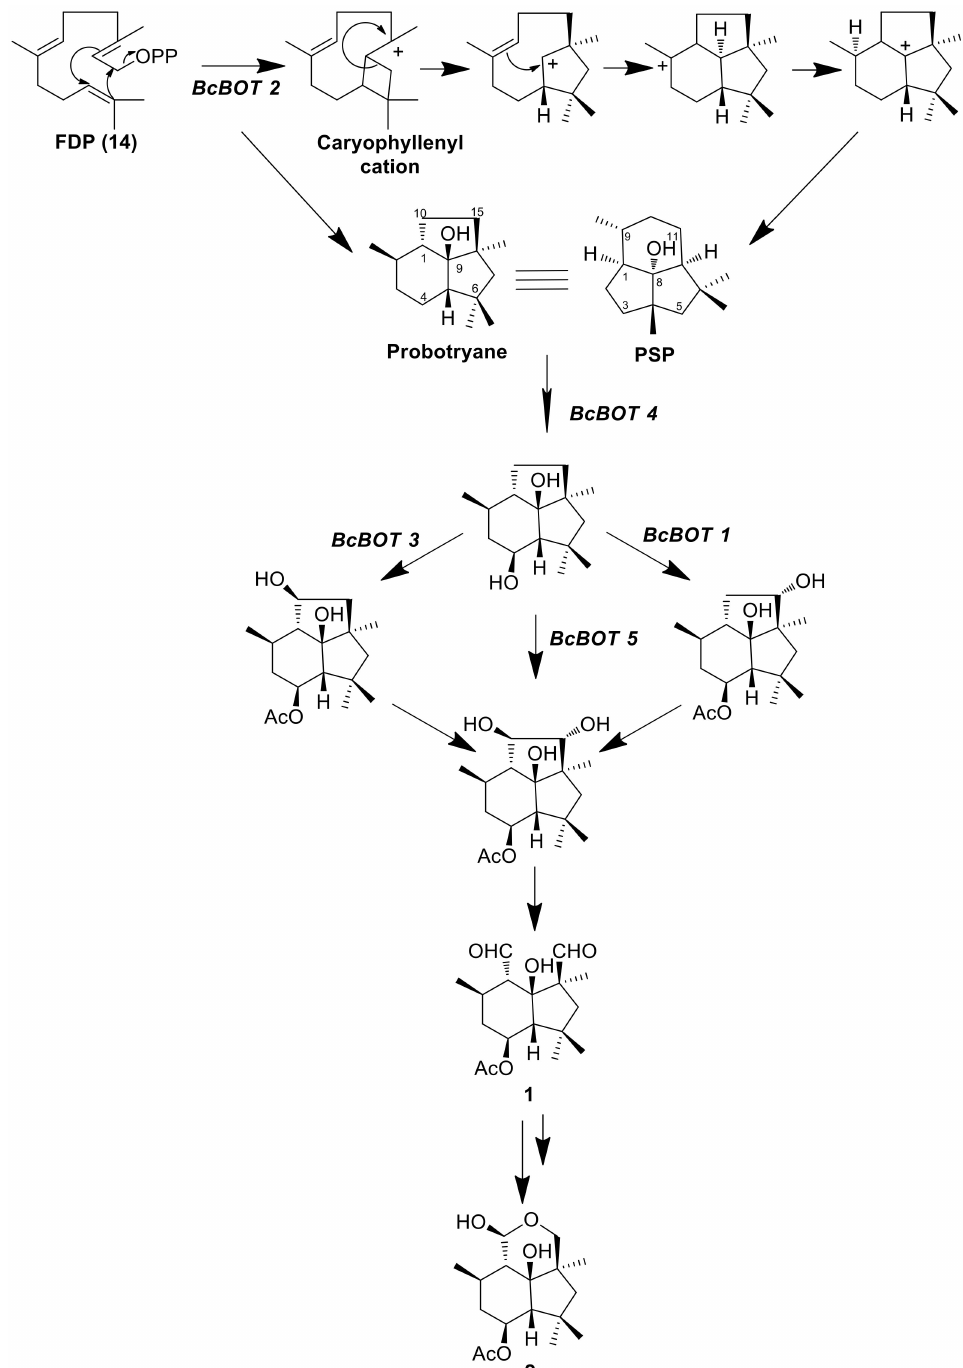
Figure 9. Biosynthetic pathway from FDP ( 14 ) to botrydial ( 1 ) and dihydrobotrydial ( 2